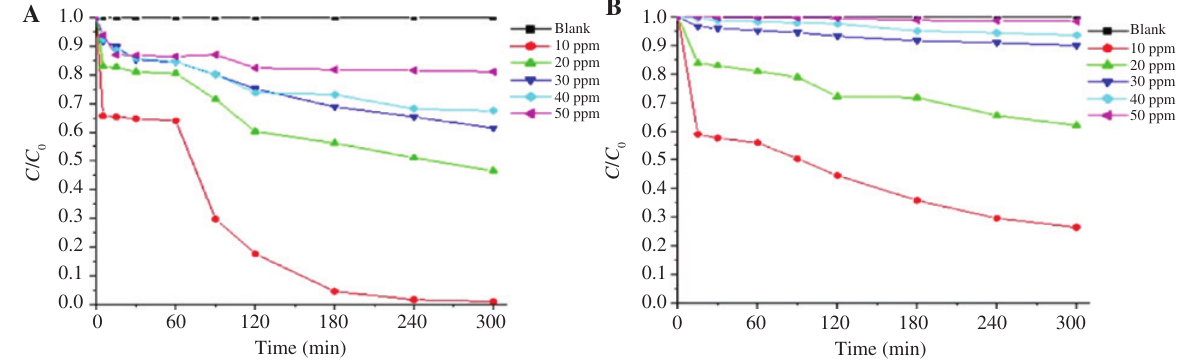
Figure 9: Effect of the initial dye concentration on the decolorization of (A) reactive black 5 and (B) methylene blue dyes.